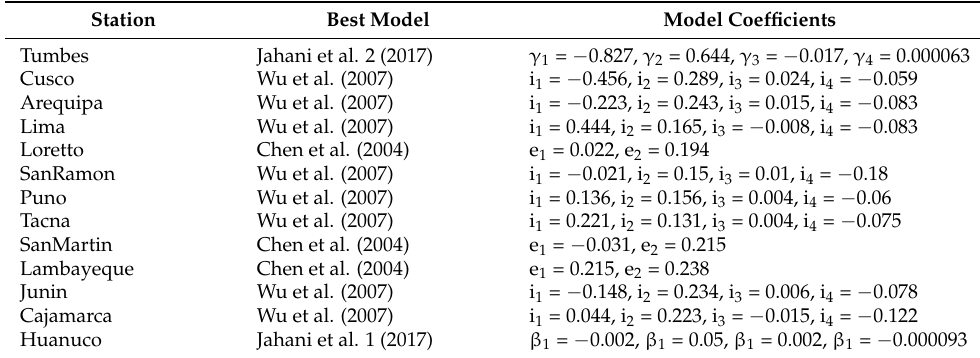
Table 3. Calibrated coefficients for the best empirical models for each station.